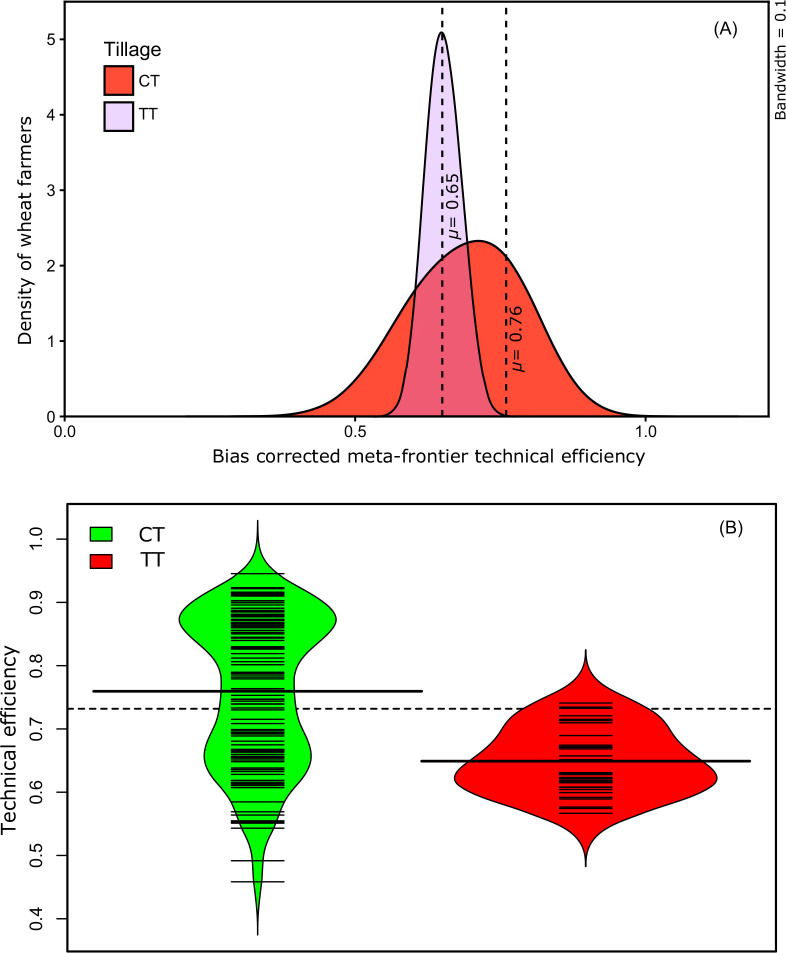
a Epanechnikov kernel density estimates of bias
corrected meta-frontier TE of CT adopters and non-adopters.
‘μ’ denotes the mean
values of bias corrected meta-frontier TE. Density curves with
orange and purple filled area show bias corrected meta-frontier TE
of CT and TT respectively. In each curve, the black dotted vertical
line represents the mean value of bias corrected meta-frontier TE. b
Technical efficiency of conservation tillage (CT) vs. traditional
tillage (TT). Bean shape is a mirror image of the variable’s
density plot, aligned vertically. The dotted line represents the
threshold technical efficiency (TE) score referring to the mean TE
of the entire sample without technology differentiation. Small
horizontal lines inside the beans for each tillage option correspond
to TE of each farmer. Thin long horizontal lines show the frontier
efficiency under each tillage category, while the bold long
horizontal lines show the mean TE of farmers in each tillage
options